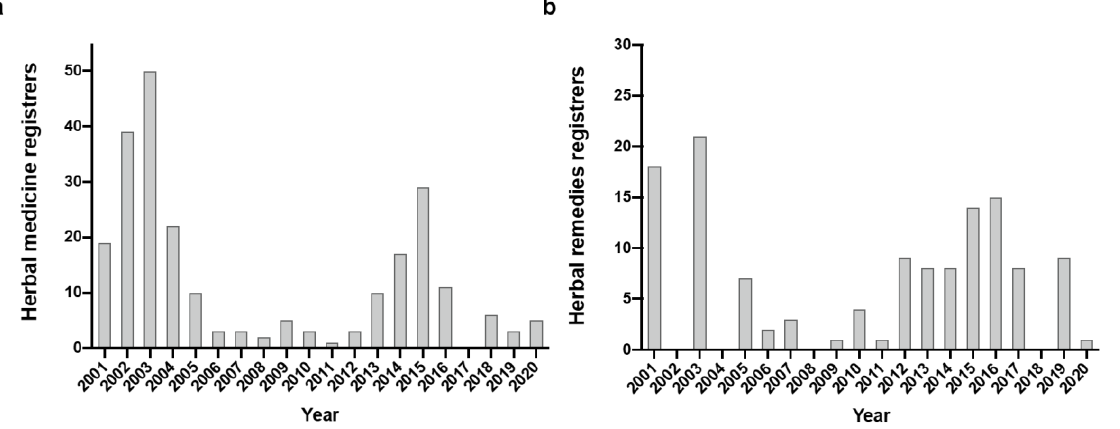
Figure 1. The number of ( a ) herbal medicine and ( b ) herbal remedies with sanitary registers in Mexico during 2001 – 2020. Data obtained from: COFEPRIS (Comisión Federal para la Prevención de Riesgos Sanitarios). 2022; Listados de Registros Sanitarios de Medicamentos. https://www.gob.mx/cofepris/documentos/registros-sanitarios-medicamentos (accessed on 12 Au-